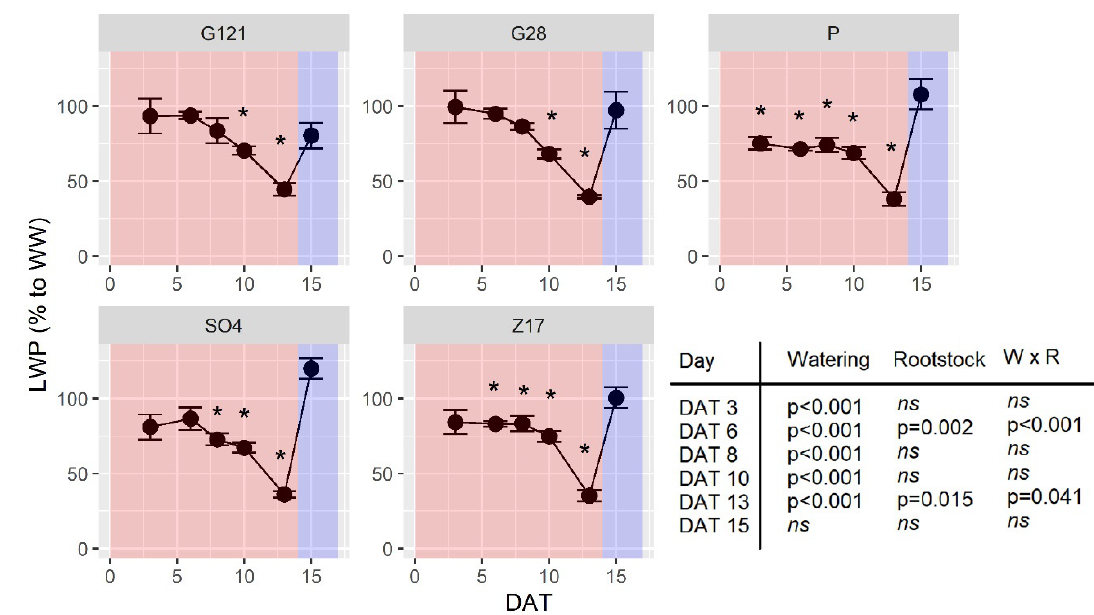
Figure 6. Changes (%) in leaf water potential (LWP) for plants subjected to water stress (WS) and compared with plants under well-watered conditions (WW) measured with a Scholander pressure bomb in five rootstocks. The p -value from two-way ANOVA is shown for each DAT and factor while ns represent non-significant differences. Asterisks represent significant differences between WW and WS for each rootstock. Data shown are means ± standard error of the means (SEM, n = 3).